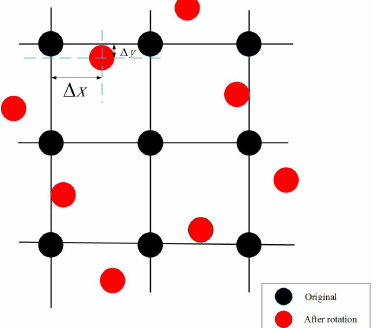
Figure 2. When the main orientation is assigned to a keypoint, the filters shown in Figure 1 ought to be rotated with respect to the main orientation. Black dots represent the integer pixel grid, and red dots are the fractional pixel locations, whosewhole values are used by the rotated